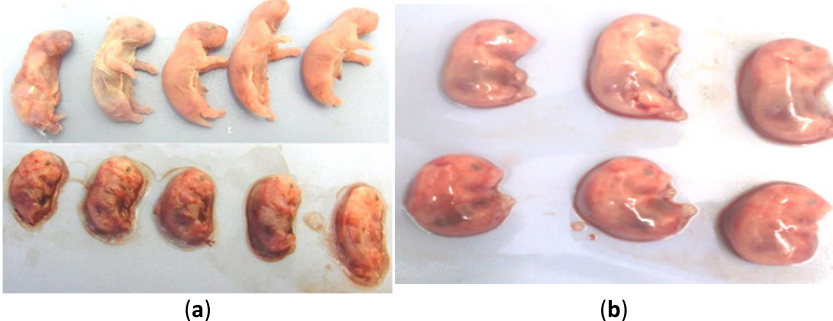
Figure 3. ( a ) Pups of pregnant hamsters inoculated with EHV-9 in the early first trimester (5th day of gestation) were congested, undersized, and found dead or stillbirth (lower row) at 11th dpi in comparison with the control (upper row) at parturition time (16 days of gestation). ( b ) Pups of pregnant hamsters inoculated with EHV-9 in the late trimester (10th day of gestation) were congested, undersized fetuses (lower raw) at 3 dpi in comparison with control fetuses at the 13th day of gestation (upper row).